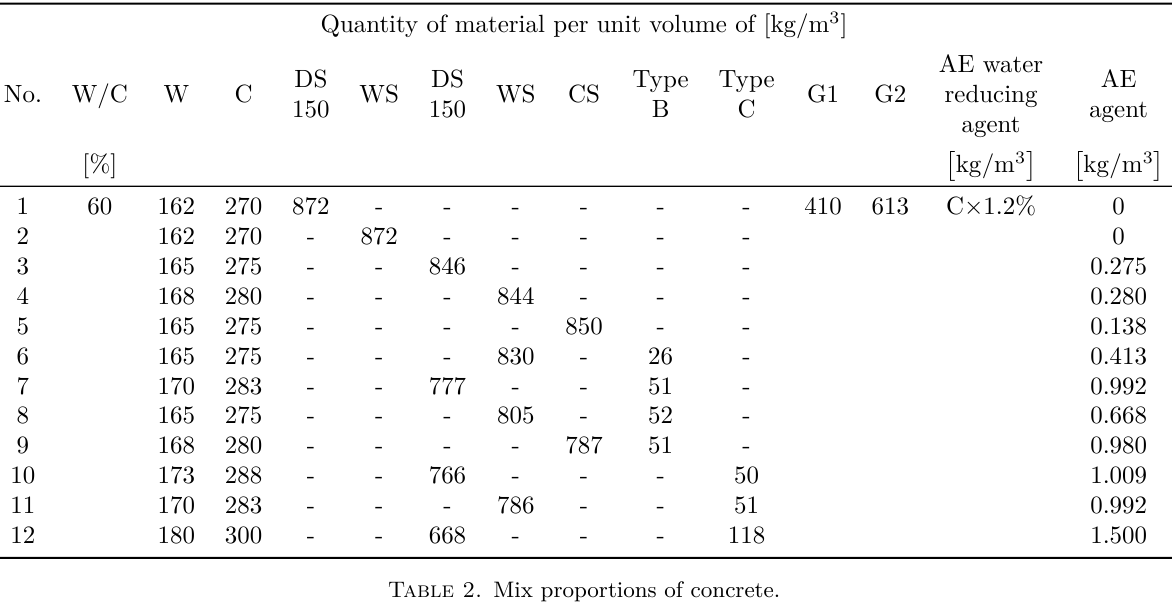
Table 2. Mix proportions of concrete.